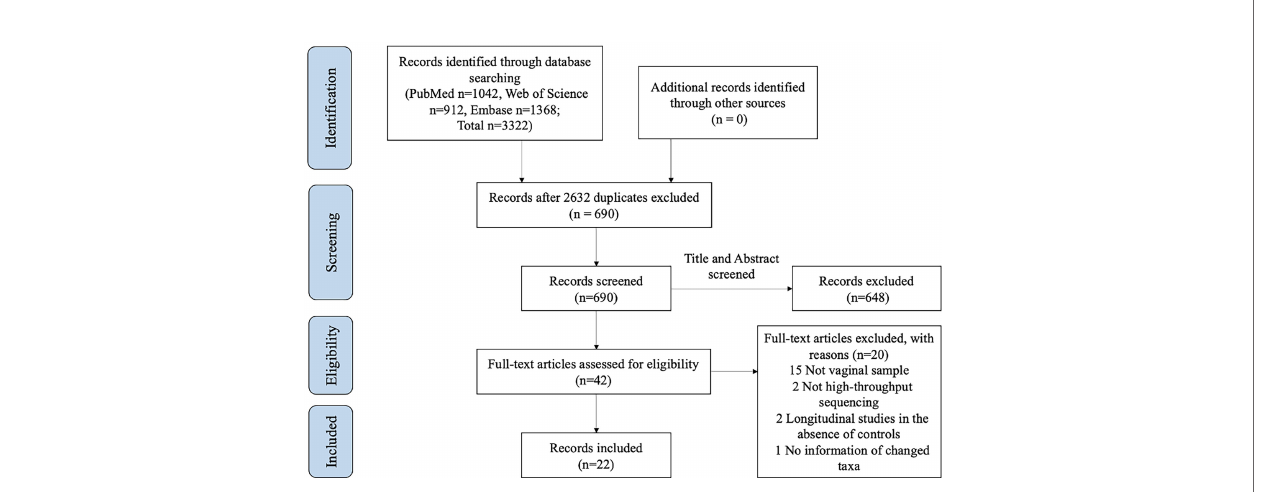
FIGURE 1 | PRISMA fl ow diagram of the study selection process for